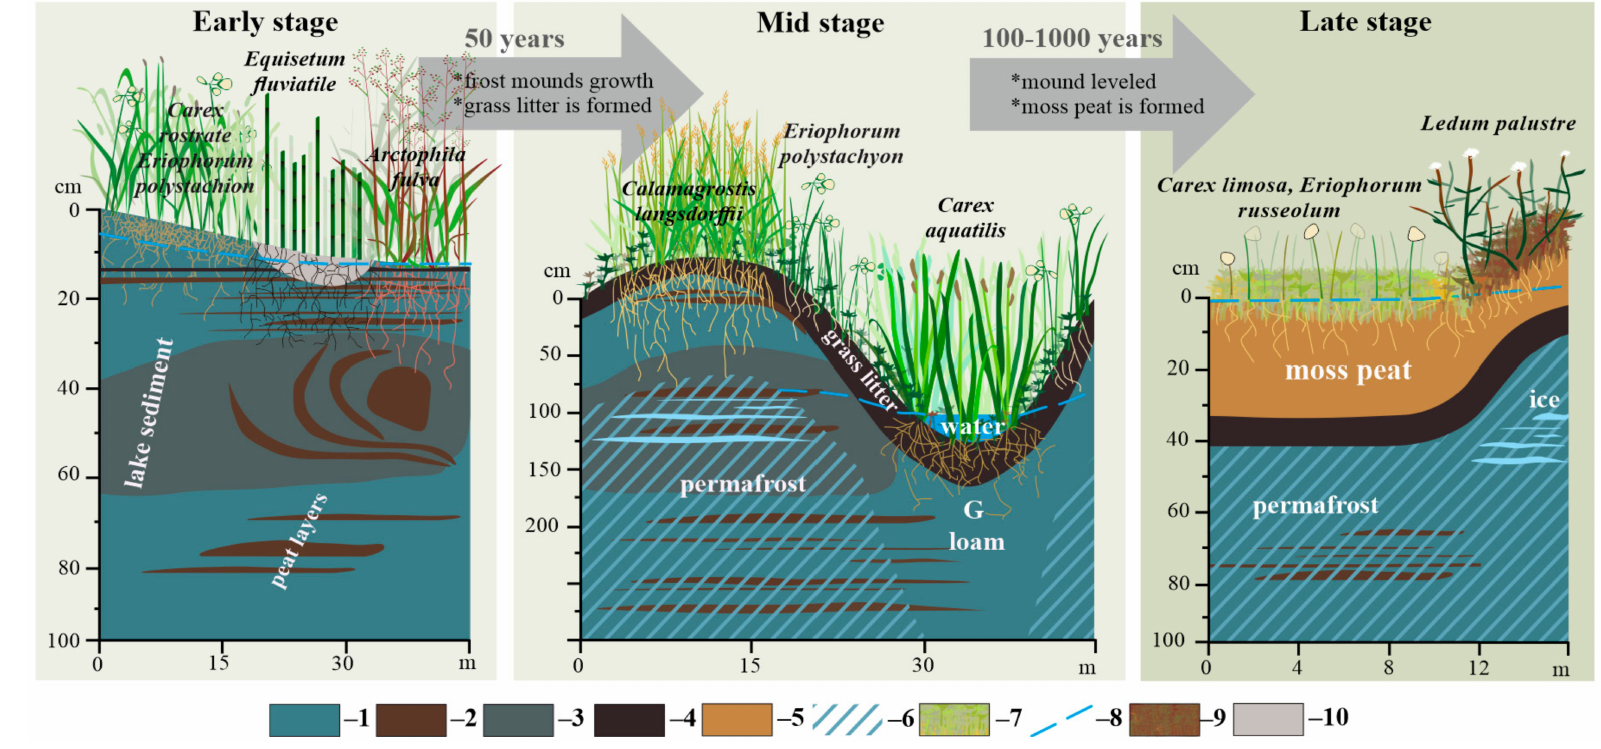
Figure 1. Vegetation and soil of the successional stages of khasyreys. 1—mineral lake sediment; 2—inclusion of redeposited peat in the sediment; 3—peat–mineral sediment; 4—grass (eutric) peat; 5—moss (dystric) peat; 6—permafrost; 7—sphagnum mosses; 8—top level of shallow ground water; 9—brown and sphagnum moss; 10—sandy layer of